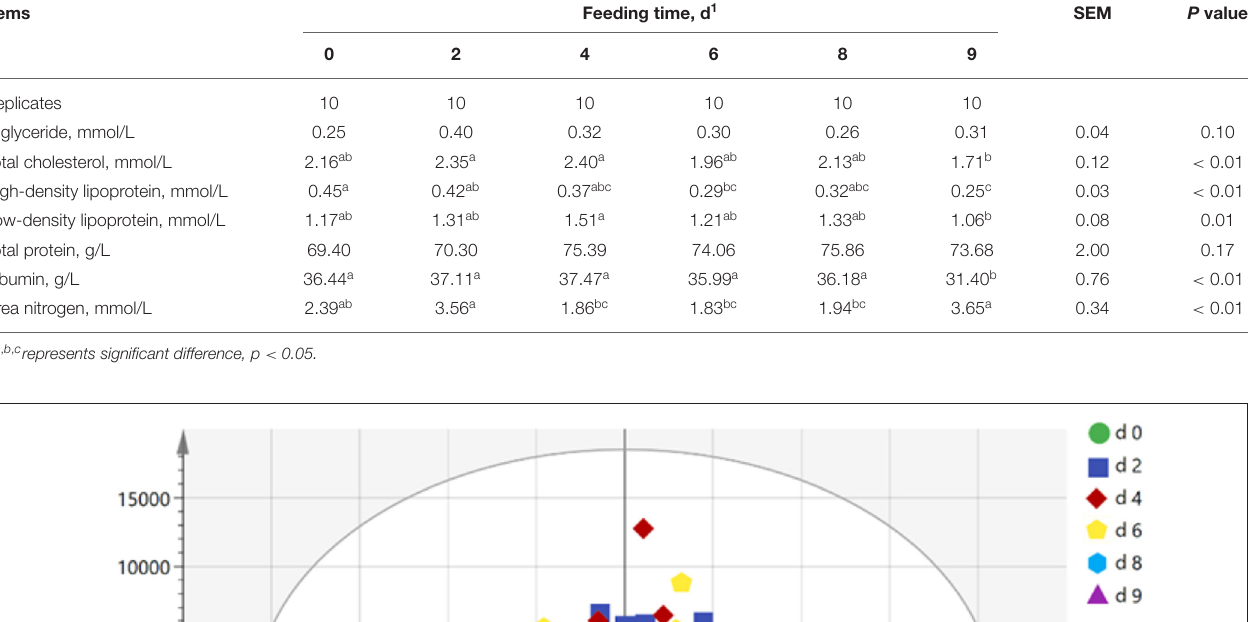
TABLE 2 | Effects of feeding level at metabolizable energy for maintenance on the concentration of plasma biochemical parameters in growing pigs. Items Feeding time, d 1